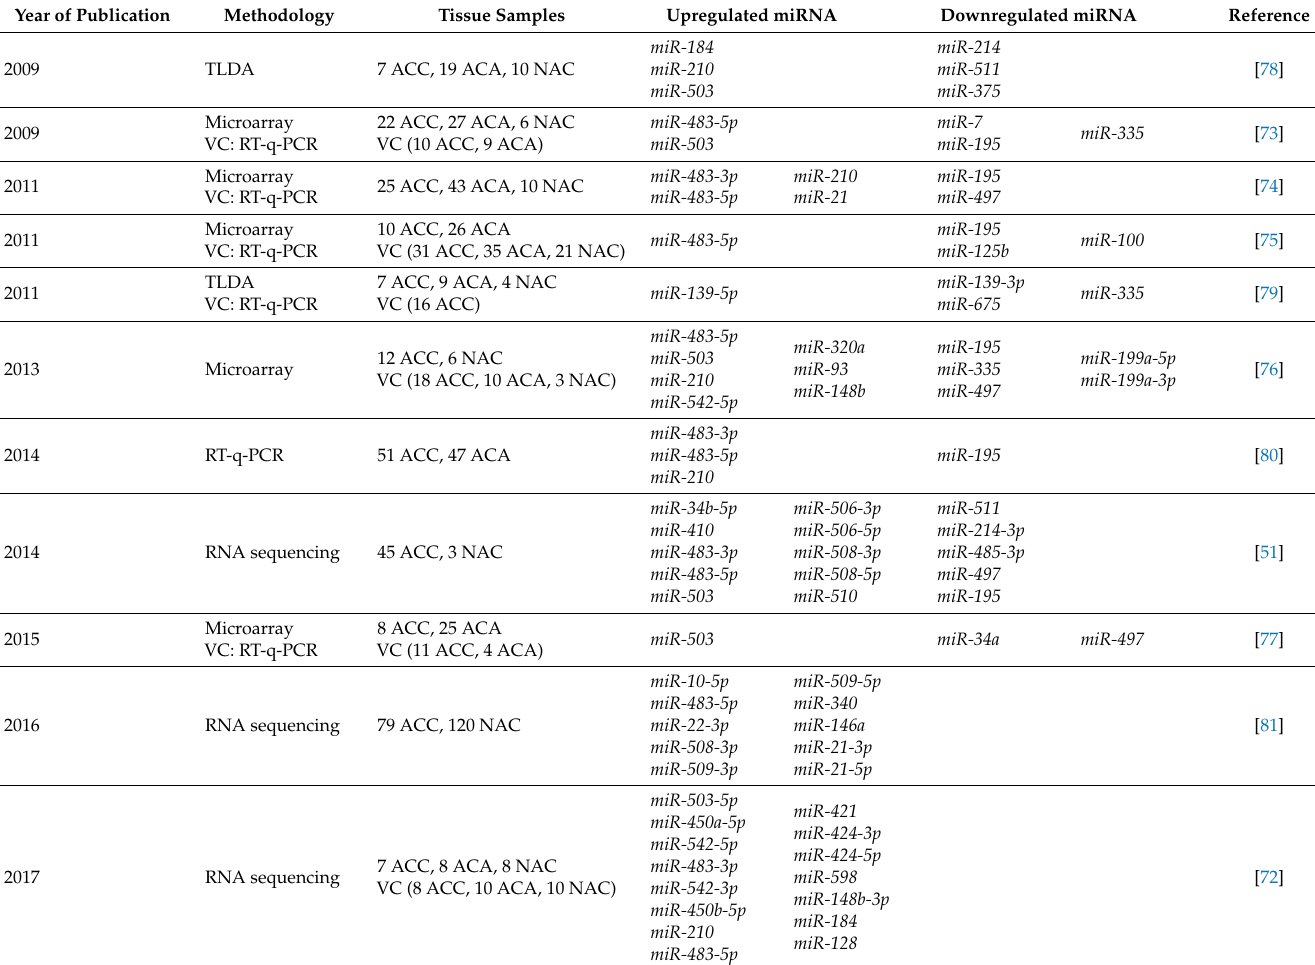
Table 2. Studies investigating di ff erential expression of microRNAs in ACC Tissues compared with ACA and